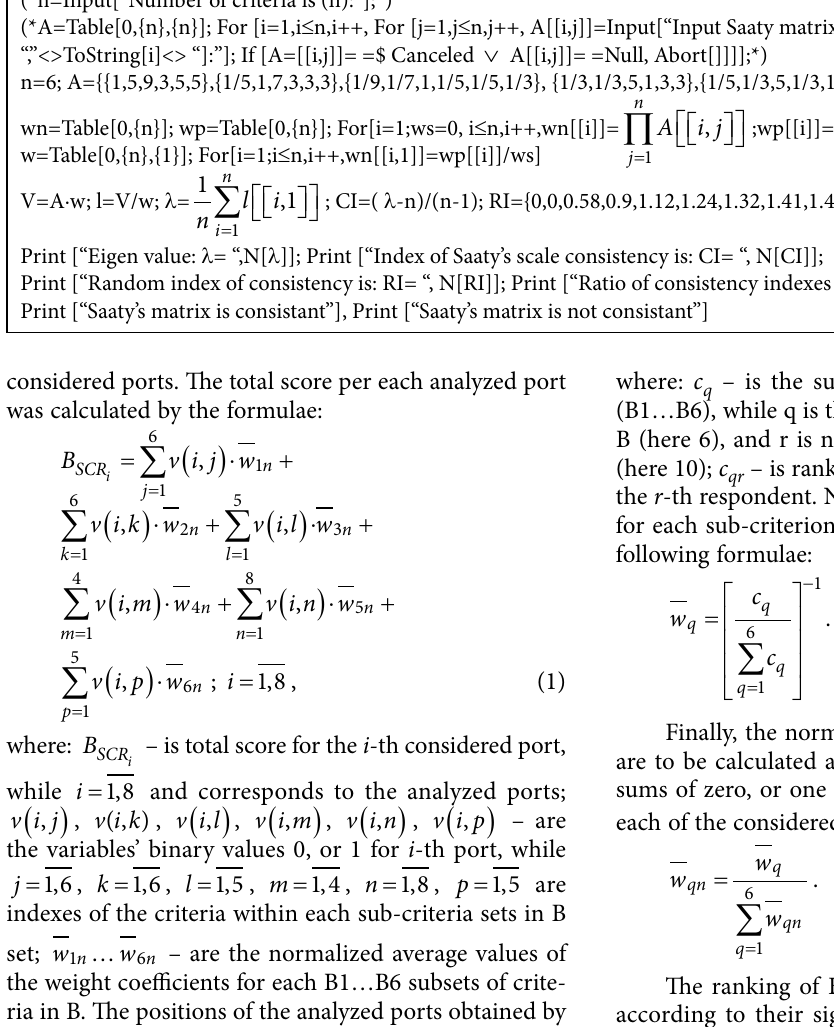
Table 9. Code 1: calculating weight coefficients and testing Saaty’s matrix consistency Code 1 : Off[General::spell1]